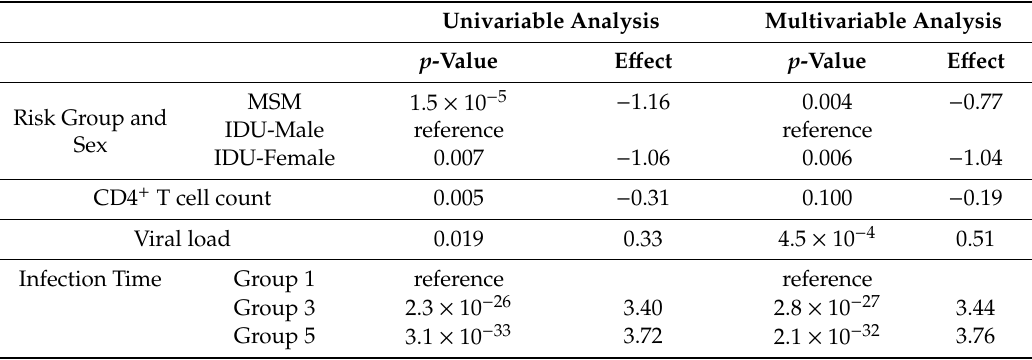
Table 3. Factors associated with the presence of broadly neutralizing antibodies in participants of the Swiss 4.5k